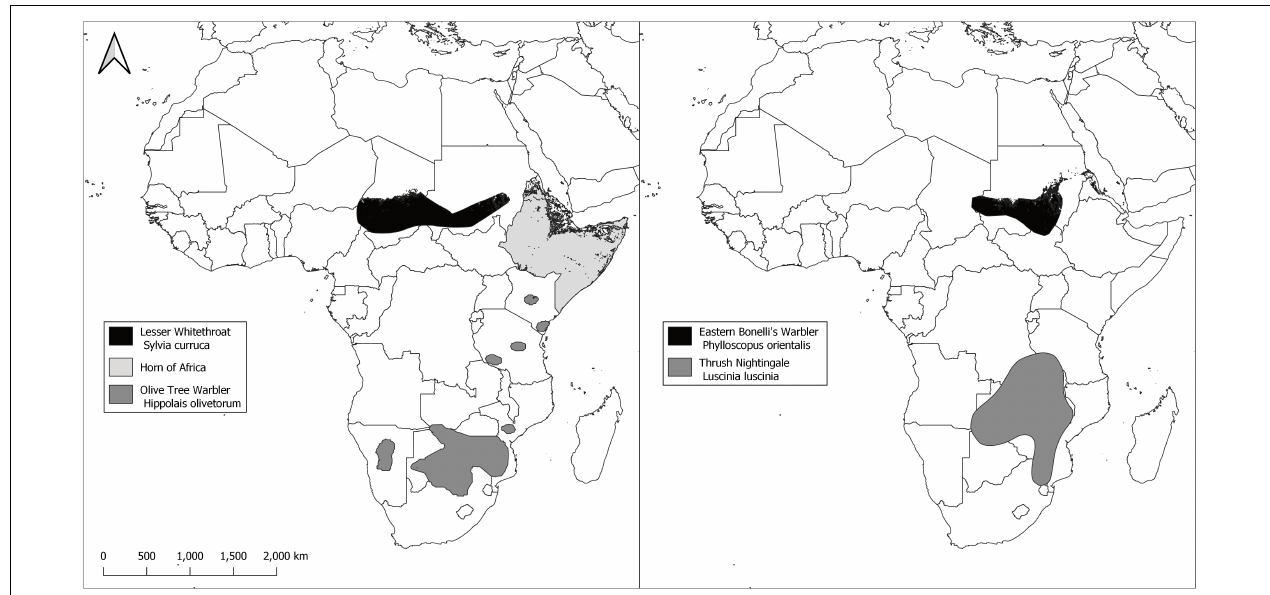
FIGURE 1 | Main Non-breeding (wintering) distribution maps of the study species along the Eastern-Mediterranean flyway. The area of Horn of Africa was used as the pre departure area for Lesser whitethroat, Thrush nightingale and Olive-tree warbler, where they are likely to spend the months prior to migration departure. GIS data downloaded from BirdLife International data zone (http://www.birdlife.org/). Enhanced Vegetation Index (EVI) was calculated for each site to be analysed against arrival timing of species to stopover site in